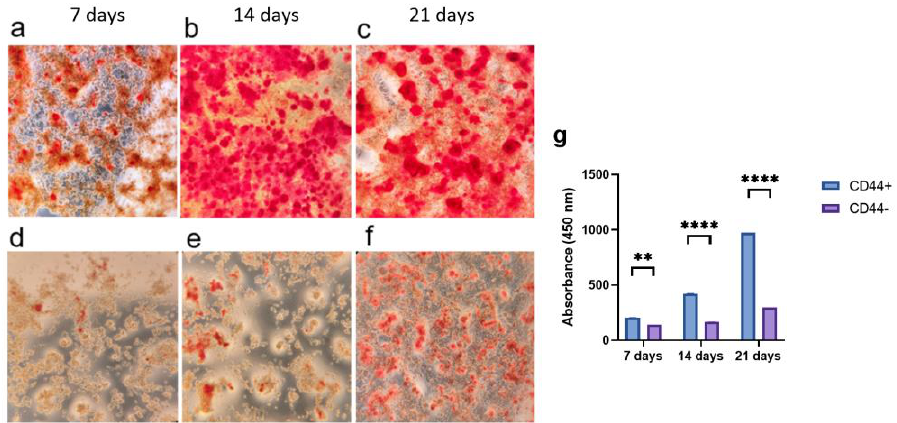
Figure 3. Osteogenic differentiation potential of CD44 + and CD44 − cells. Formation of mineralized nodules by CD44 + cells after 7 ( a ), 14 ( b ), and 21 days ( c ); and CD44 − cells after 7 ( d ), 14 ( e ), and 21 days ( f ). Quantification of Alizarin Red S staining ( g ). All microphotographs are at 40 × magnification. CD44 + —CD44-positive cells, CD44 − —CD44-negative cells, ** p ≤ 0.01, and **** p ≤ 0 .0001.